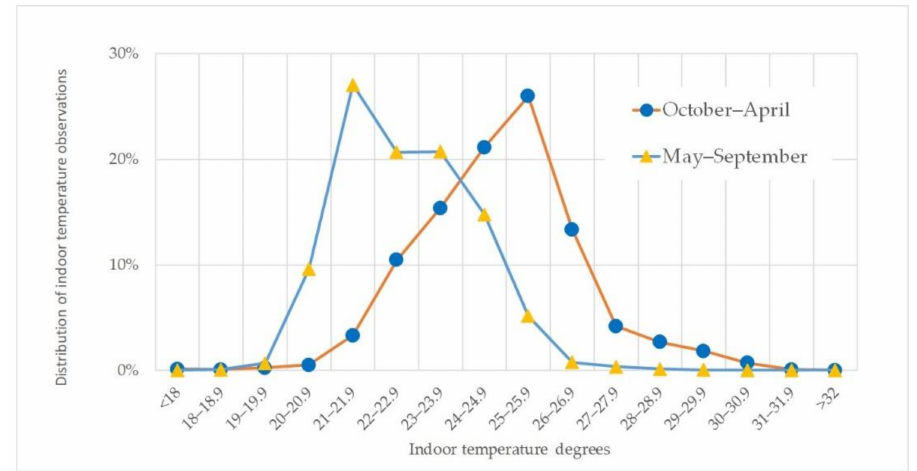
Figure 9. The distribution of indoor temperature observations in five dwellings from February 2017 to April 2020 (after-renovation values). Table 5. Average temperatures and temperatures within the